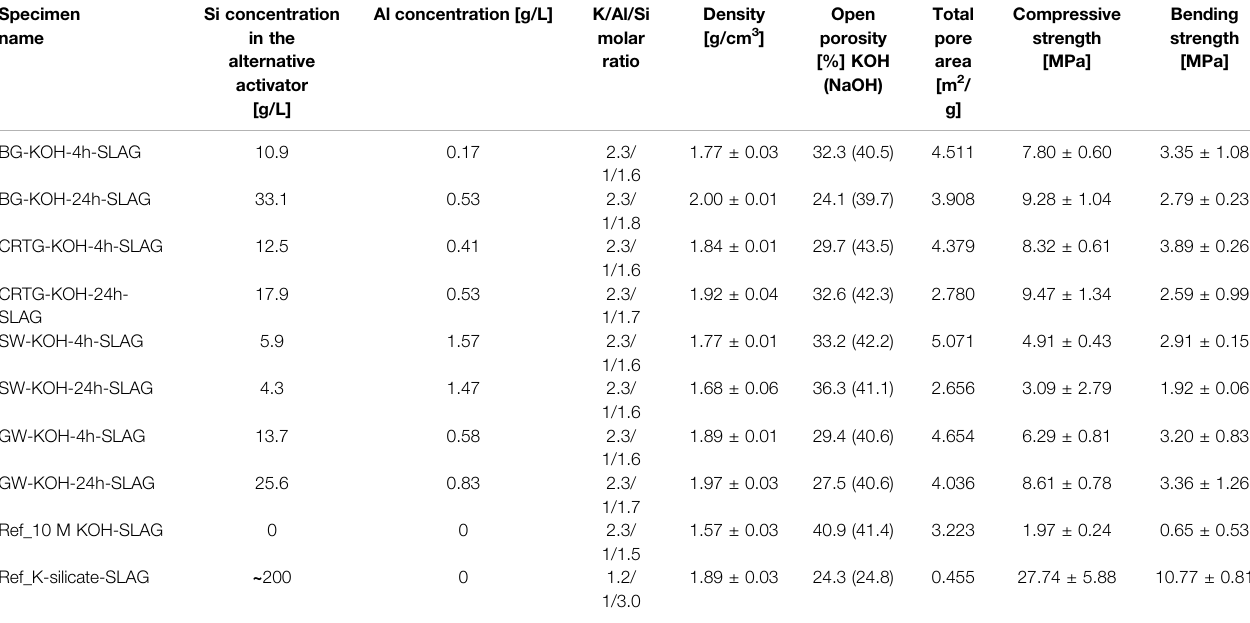
TABLE 4 | Concentrations of dissolved Si and Al in the AAAs, the molar ratio of K/Al/Si in the prepared pastes, and the density, porosity and mechanical strength of the hardened slag (EAFS) binders. The K/Al/Si molar ratio in the prepared mixtures is calculated from the chemical composition obtained by XRF and XRD of the EAFS. The numbers in brackets refer to dissolution in NaOH (König et al.,